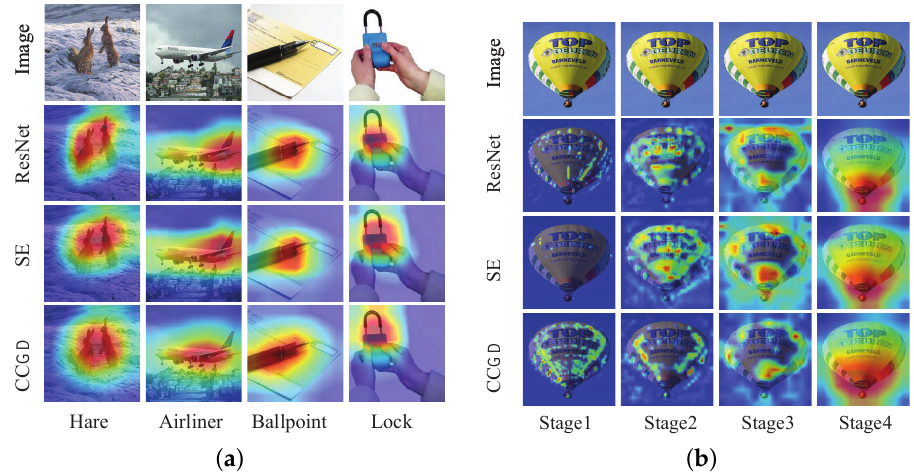
Figure 6. Visualization of class activation mapping using ResNet50, SENet50, and CCGDNet50 as backbone networks: ( a ) CAM of different objects; ( b ) CAM at different